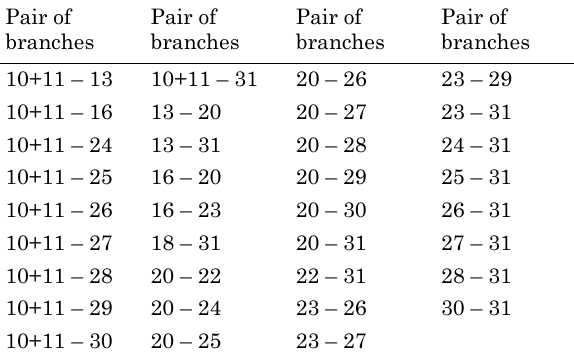
Table 6. Statistically significant differences between each pair of means of efficiency